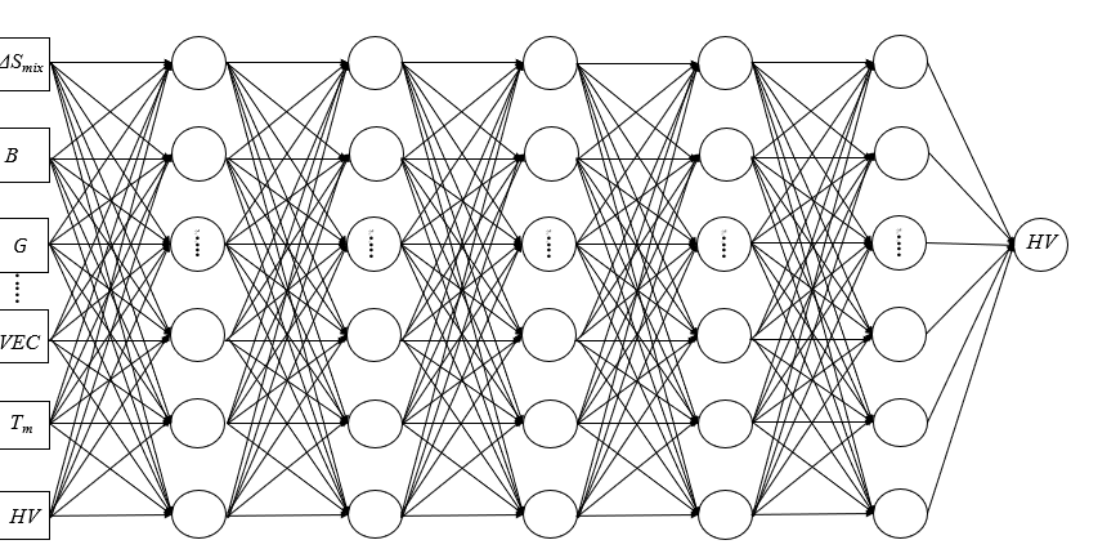
Figure 2. A schematic model of the neural network (NN) showing 5 hidden layers. The input consists of HEAs features as represented by square boxes on the left.